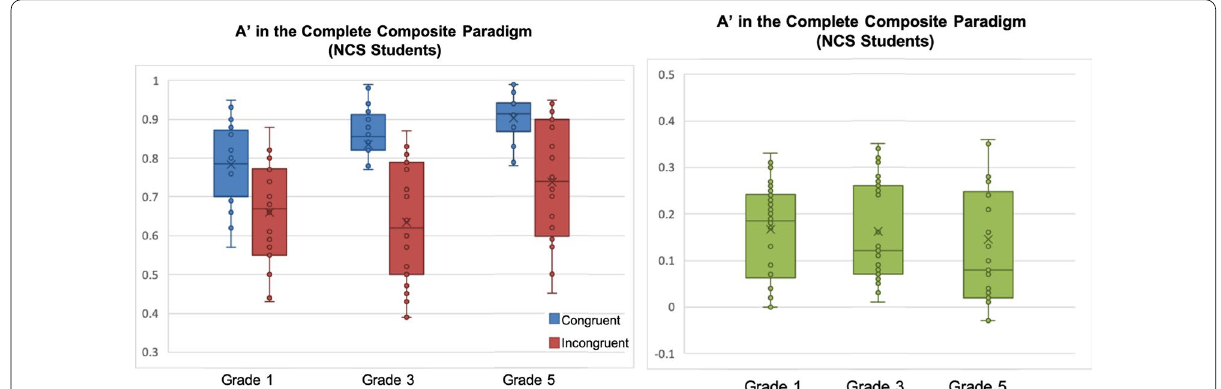
Fig. 5 A ′ of congruent and incongruent trials (left) and Holistic A ′ in for non‑Chinese‑speaking first, third and fifth graders in the holistic processing task (right)